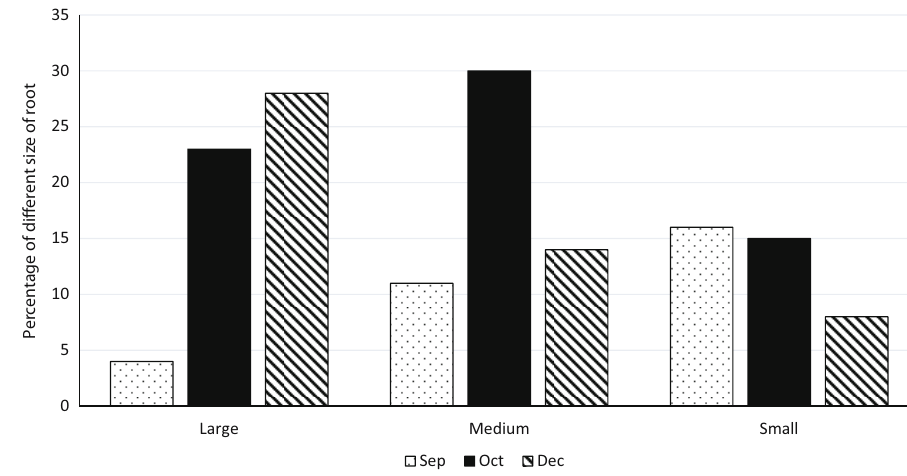
Figure 3: Percent of large, medium, and small sizes of roots in September, October and December